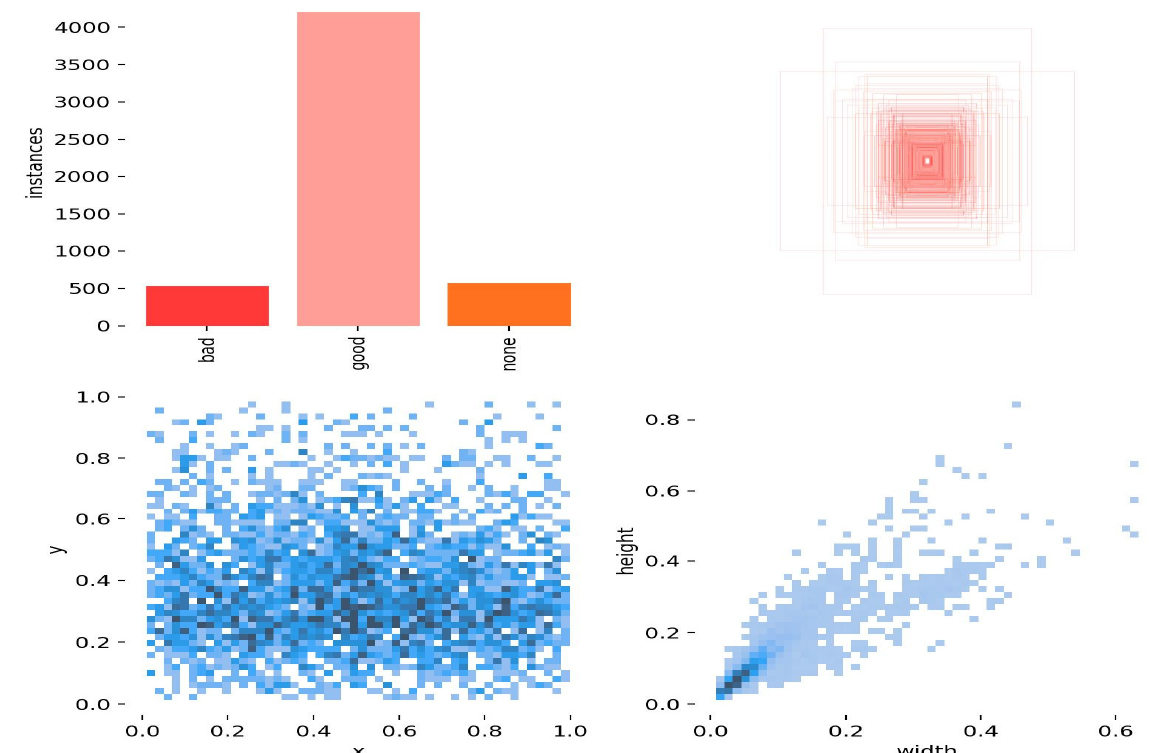
Figure 5. Labels of MMD and FMD dataset.